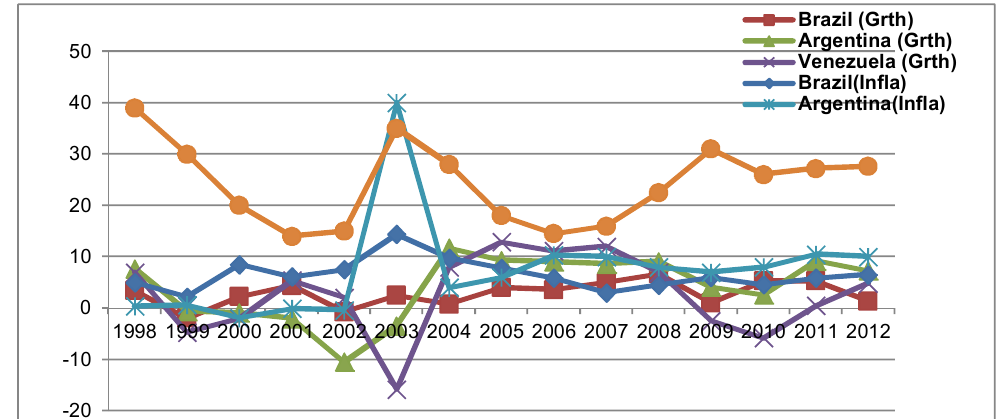
Figure 7: Growth and Inflation Trends of Countries